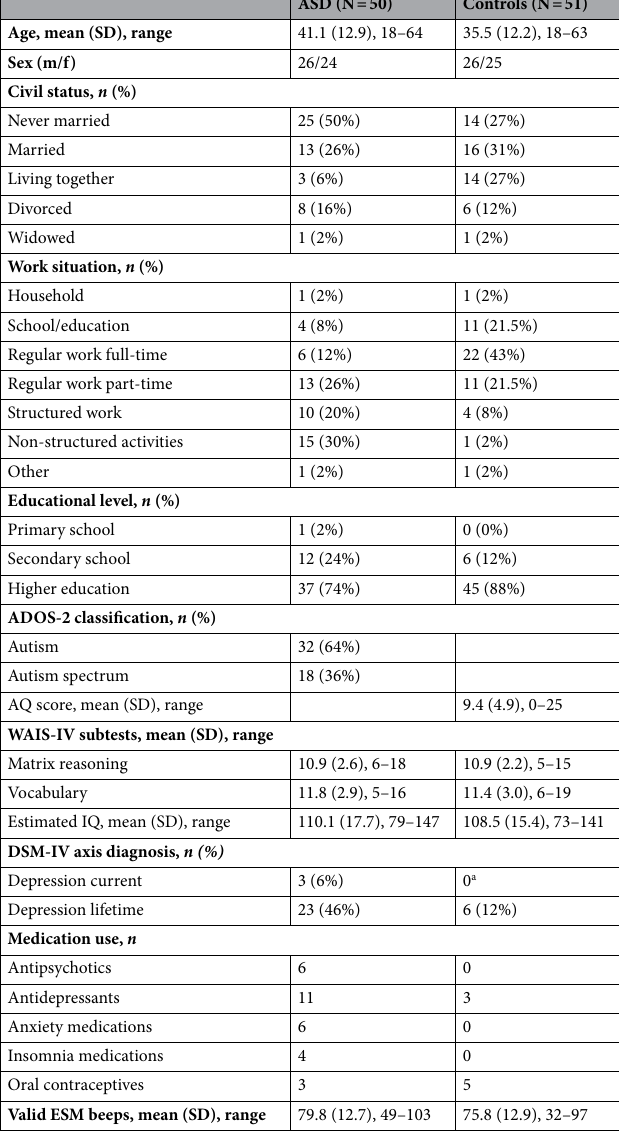
Table 1. Sociodemographic and clinical characteristics of the research sample. ASD, Autism spectrum disorder; ADOS-2, Autism Diagnostic Observation Schedule II; AQ, the Autism Spectrum Quotient;